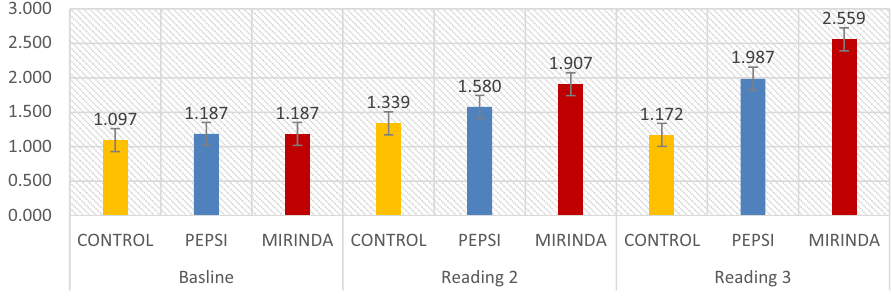
Figure 1. Solution with each surface roughness